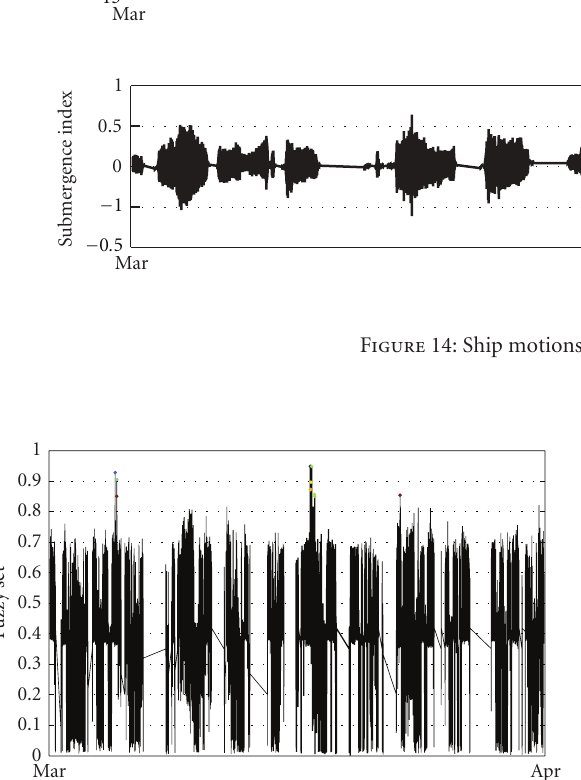
that for the starboard unit negative roll angles lead to lower propeller submergences.